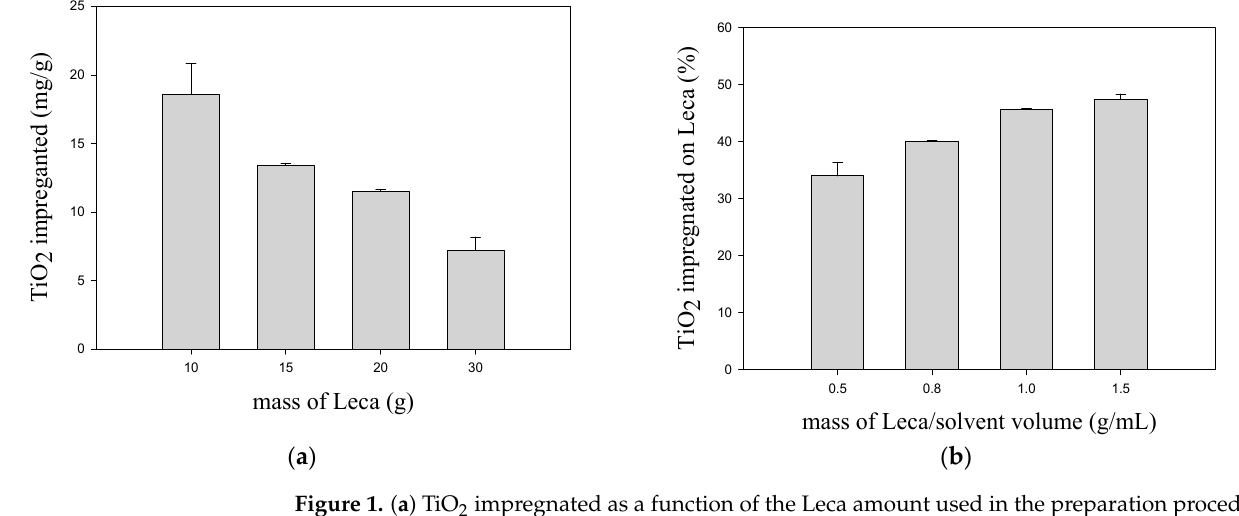
Figure 1. ( a ) TiO 2 impregnated as a function of the Leca amount used in the preparation procedure; ( b ) TiO 2 impregnated yield as a function of the S/L ratio (using as TiO 2 load in the suspension 500 mg and 19.5 mL of solvent volume).